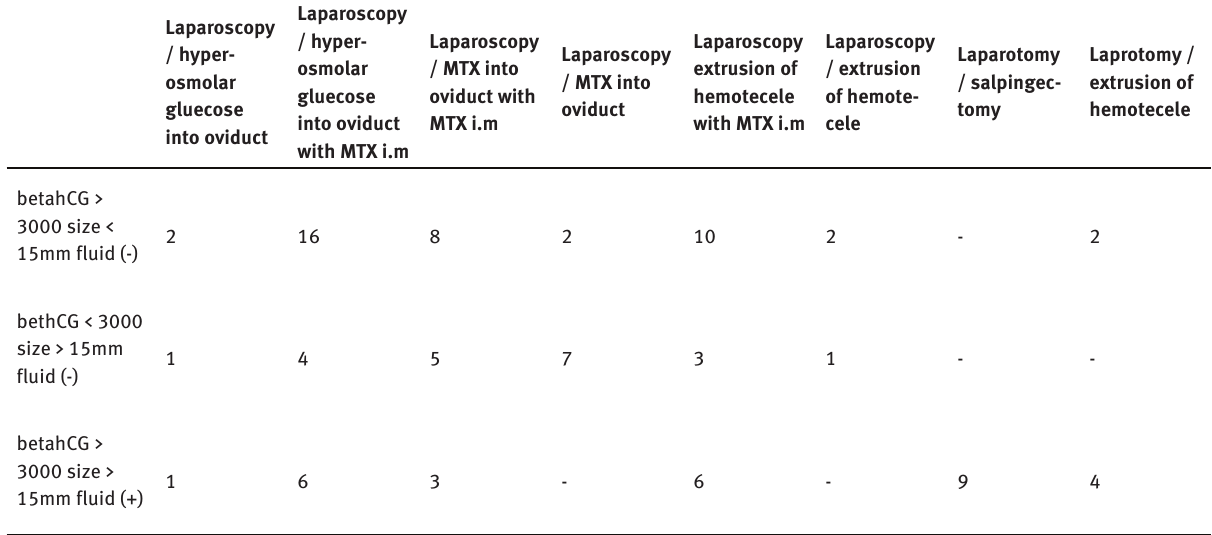
Table 4: Type of operation depending on the fulfilled parameters of categorisation.